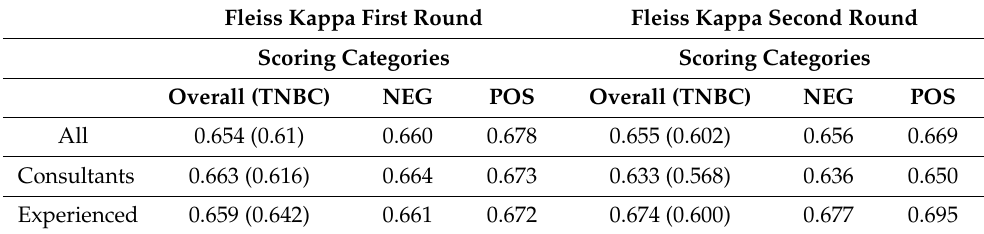
Table 4. Fleiss Kappa of agreement between the pathologists in both